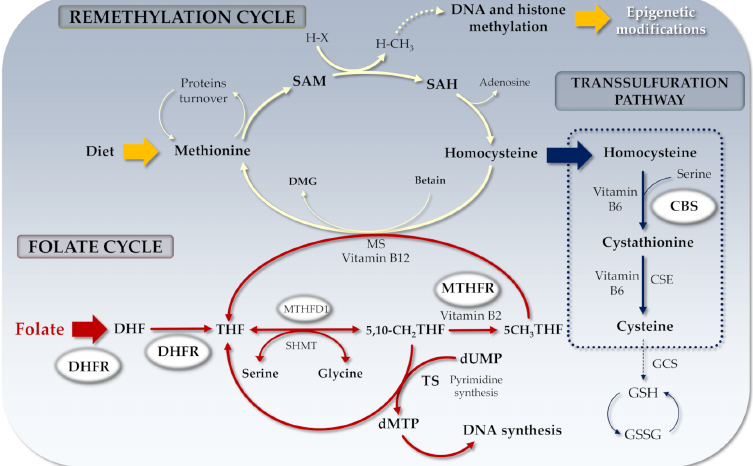
Figure 1. Folate cycle and related genes. DHF: Dihydrofolate; THF: Tetrahydrofolate; SAM: S- adenosyl methionine; SAH: S-adenosyl Homocysteine; MTHFR: Methylenetetrahydrofolate reduc- tase; RCF: Reduced folate carrier; DHFR: Dihydrofolate reductase; dUMP: Uridine monophos- phate; dTMP: Thymidine monophosphate; DMG: Dimethylglycine; MS: Methionine synthase; CBS: Cystathionine- β -synthase; H-X: Methyl acceptor; H-CH 3 : Methylated acceptor; TS: Thymidylate syn- thase; MTHFD1: Methylenetetrahydrofolate dehydrogenase-1 (NADP+ dependent); CSE: Cystathio- nine γ -lyase; GCS: γ -glutamylcysteine synthetase; GSH: Glutathione; GSSG: Glutathione